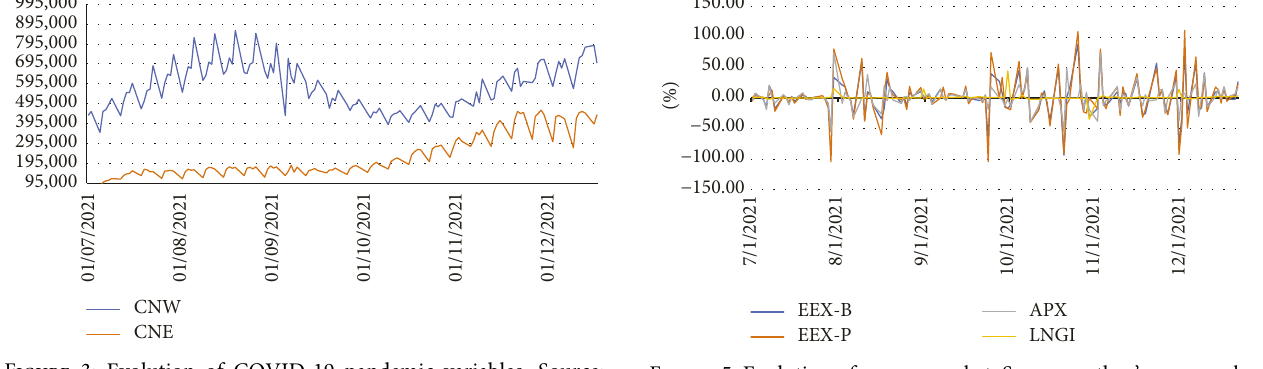
Figure 5: Evolution of energy market. Source: author’s own